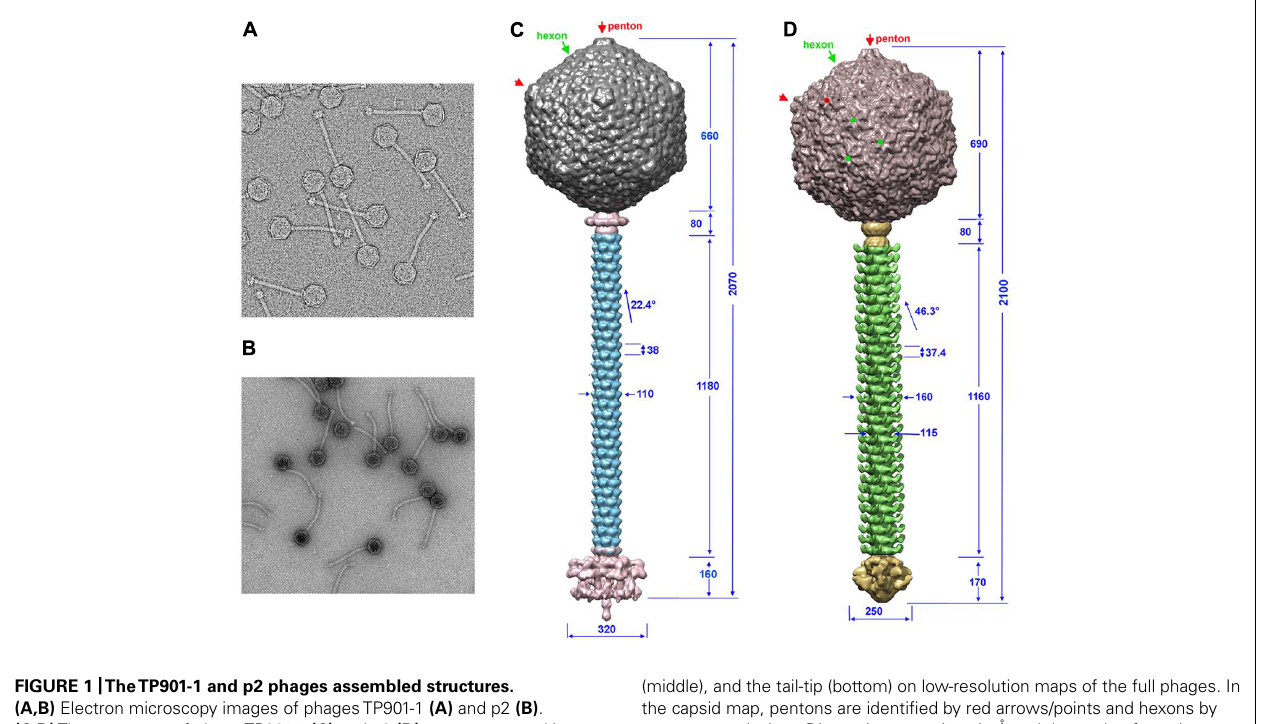
(middle), and the tail-tip (bottom) on low-resolution maps of the full phages. In the capsid map, pentons are identified by red arrows/points and hexons by green arrows/points. Dimensions are given in Å and the angle of rotation between MTP hexamers is given in